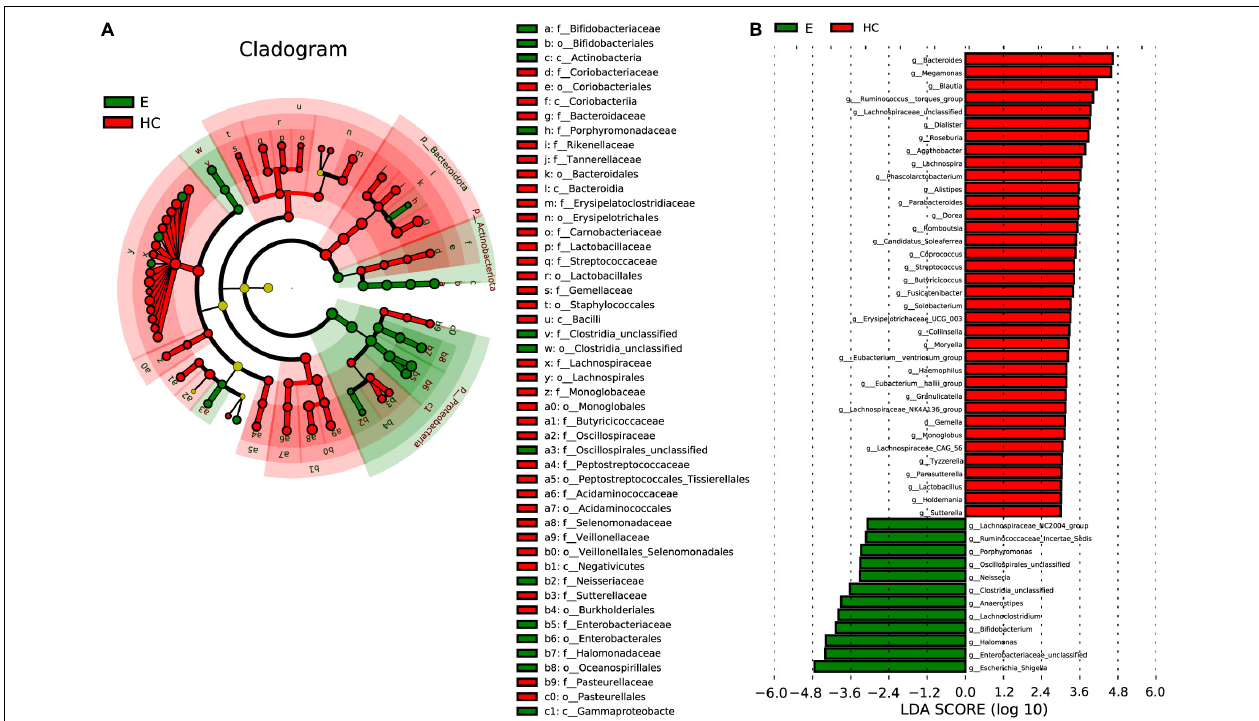
FIGURE 6 | LEfSe analysis and LDA based on OTU characterizations of the microbiota in Eps ( n = 24) and HCs ( n = 50). (A) Cladogram generated by the LEfSe method showing the phylogenetic distribution of fecal microbiomes associated with Eps and HCs. Each filled circle represents one phylotype. Phylum and class are indicated by names on the cladogram. Order, family, and genus are listed in the right panel. Circle size is proportional to phylotype abundance. By default, the taxonomic levels are arranged outward from phylum to genus. Red circles on the branches represent microbial communities playing pivotal roles in epilepsy. Green circles represent microbial groups playing important roles in HCs. Yellow circles represent microbial groups of little significance in either group. The default criteria LDA > 3 and P < 0.05 indicate different species and a higher abundance in one group than in the other. (B) Histogram of LDA scores calculated for selected taxa showing significant differences in microbe type and abundance between Eps (green) and HCs. LDA scores on a log10 scale are indicated at the bottom. The significance of the microbial marker increases with the LDA score. Eps, patients with epilepsy; HCs, healthy controls; OTUs, operational taxonomic units; LEfSe, linear discriminant analysis effect size; LDA, linear discriminant